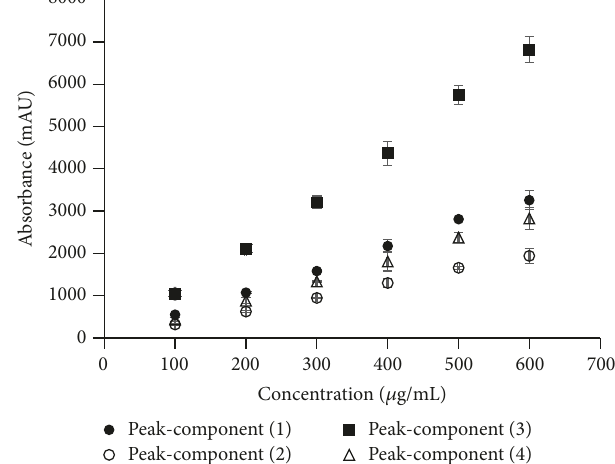
Figure 2: Calibration curve for the four peaks-components present in the hexane fraction from L. frutescens leaves (Mean ± SD, 𝑛 = 3